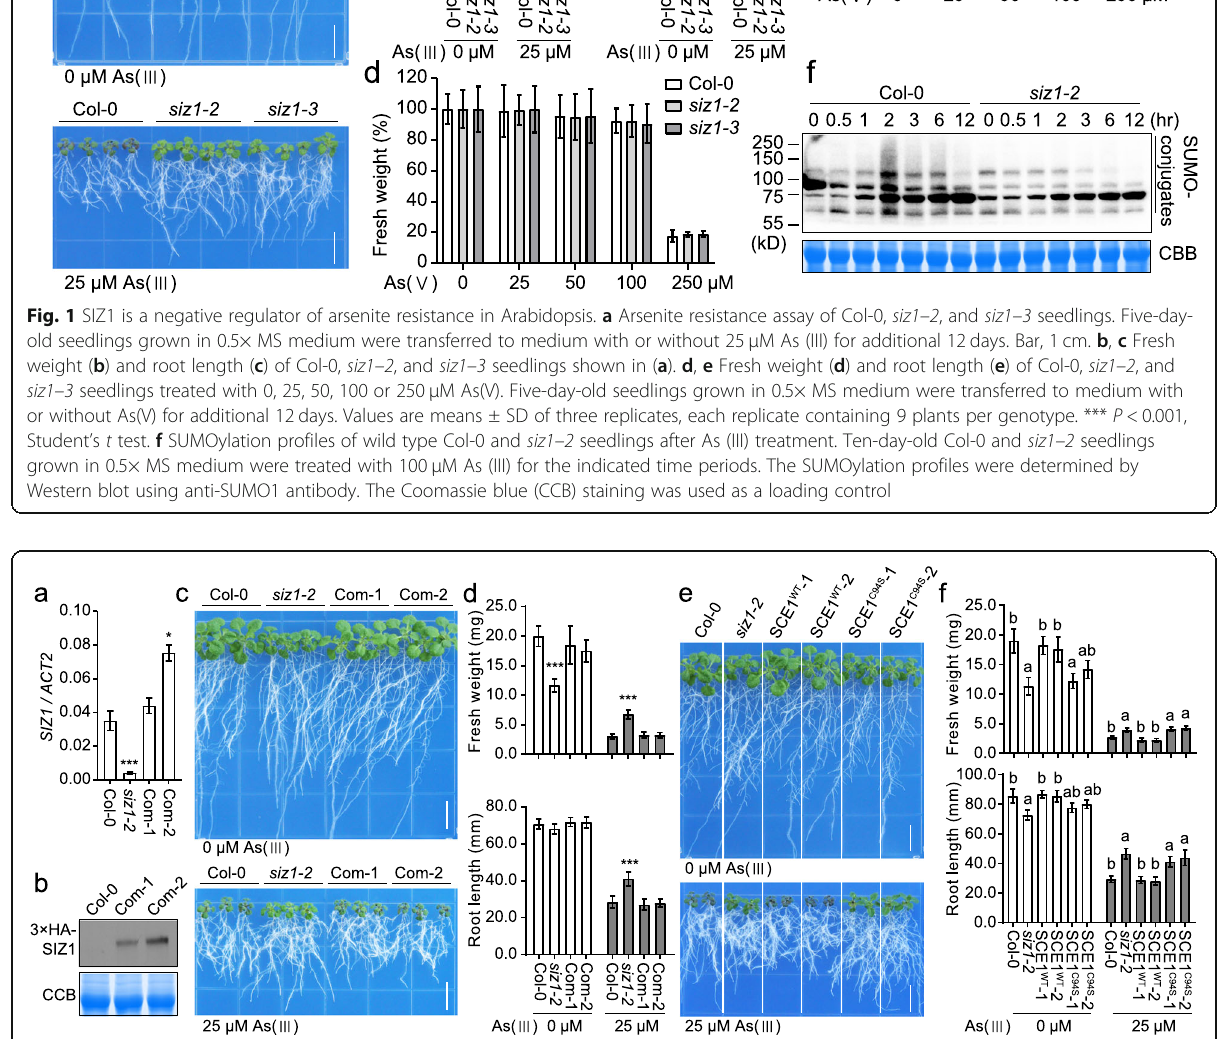
Fig. 2 Molecular complementation and mimicking siz1 – 2 arsenite-resistance phenotype by dominant-negative SCE1 overexpression. a Transcript levels of SIZ1 determined by qRT-PCR in 18-day-old Col-0, siz1 – 2 , Com-1, and Com-2 seedlings. Com-1 and Com-2 are two independent complementation lines of siz1 – 2 plants expressing the SIZ1pro:3 × HA-SIZ1 transgene. ACT2 was used as an internal control. b Immunoblot analysis of 3×HA-SIZ1 in Col-0, Com-1, and Com-2 plants. The Coomassie blue (CCB) staining was used as a loading control. c Arsenite resistance assay of Col-0, siz1 – 2 , Com-1, and Com-2 plants. Five-day-old seedlings grown on 0.5× MS medium were transferred to medium with or without 25 μ M As (III), and the photograph were taken after treatment for 12days. Bar, 1cm. d Fresh weight and root length of Col-0, siz1 – 2 , Com-1, and Com-2 shown in ( c ). Values are means ± SD of three replicates, each replicate containing 9 plants per genotype. *** P <0.001, Student ’ s t test. e Arsenite sensitivity assay of Col-0, siz1 – 2 and transgenic lines expressing the E2 conjugation enzyme SCE1. Five-day-old seedlings grown on 0.5× MS medium were transferred to the medium containing 0 or 25 μ M As (III) and treated for 12days. SCE1 WT -1 and SCE1 WT -2, two independent lines of 35S:SCE1 WT -3×FLAG in Col-0 plants. SCE1 C94S -1 and SCE1 C94S -2, two independent lines of 35S:SCE1 C94S -3×FLAG in Col-0 plants. Bar, 1cm. f Fresh weight and root length measured from the seedlings shown in ( e ). Values are means ± SD of three replicates, each replicate containing 9 plants per genotype. The letters a and b above columns indicate significant difference relative to Col-0 and siz1 – 2 mutant, respectively ( P <0.01, Student ’ s t